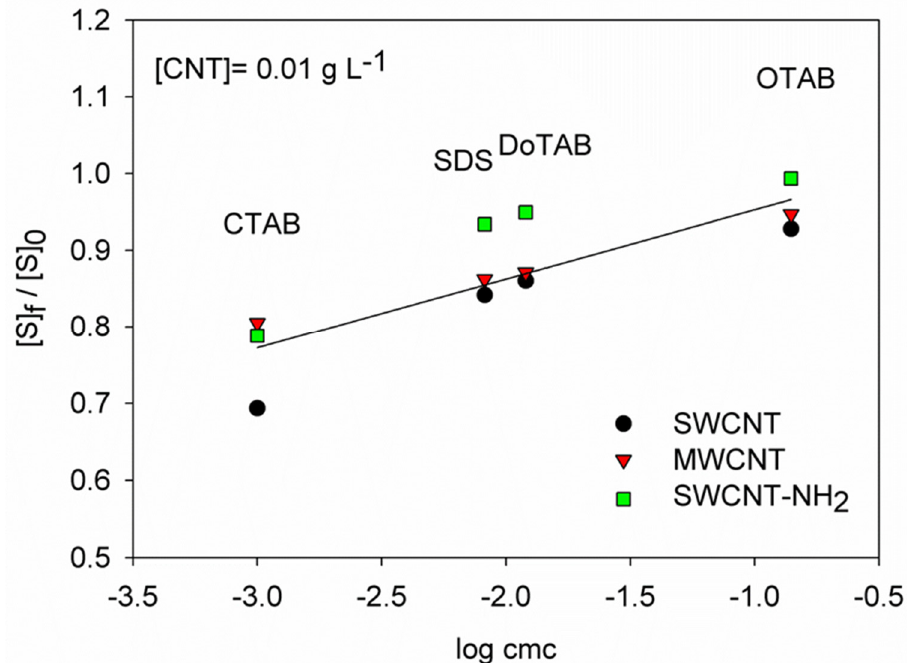
Figure 4. Plot of [S] f /[S] 0 , at [CNT] = 0.01 g L −1 , versus log ( cmc /mol dm −3 ) for all ionic surfactants and CNTs